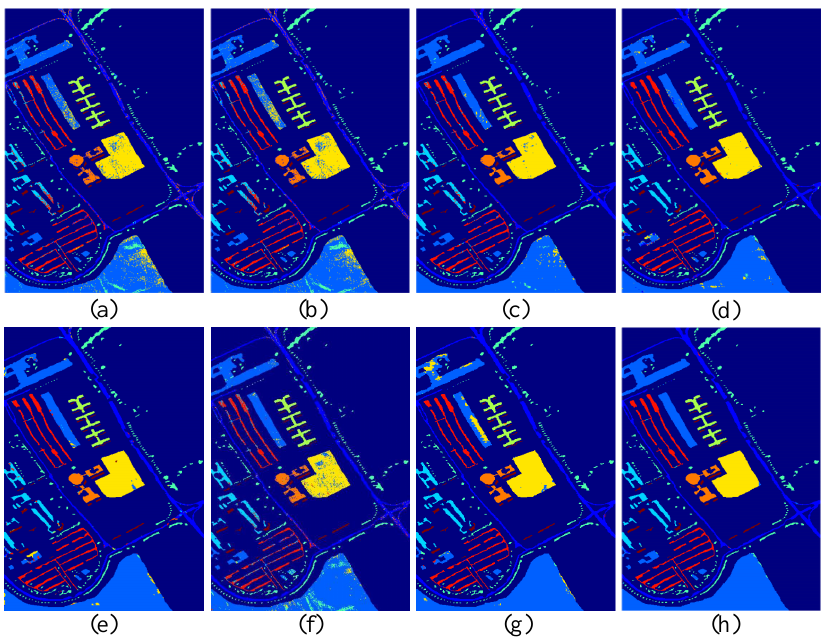
Figure 9. Classification maps using eight different methods on the Pavia University dataset: ( a ) original; ( b ) RLDE; ( c ) MDA; ( d ) 2D-CNN; ( e ) 3D-CNN; ( f ) LSTM; ( g ) CNN+LSTM; ( h )